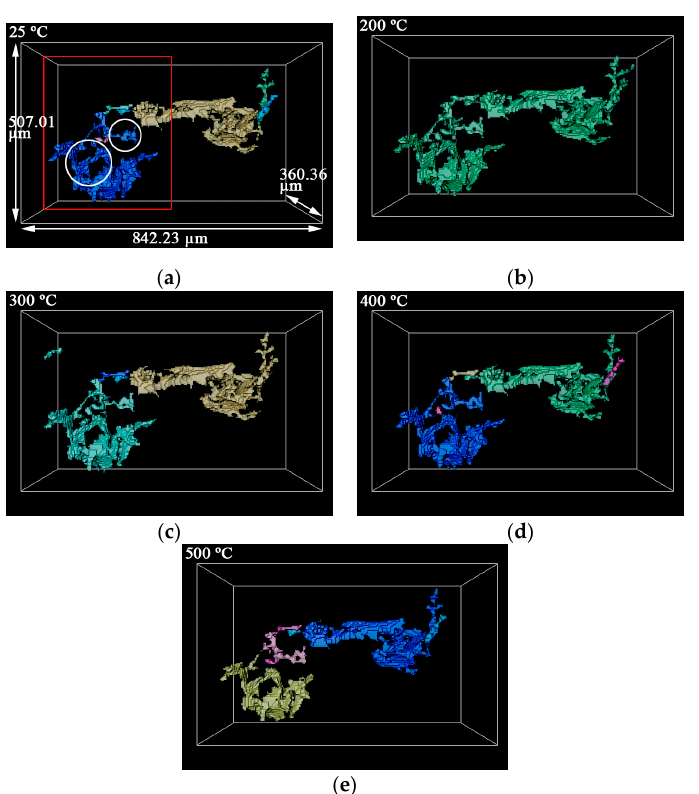
Figure 9. The 3D images of the shape and size change of some branched crack-like (Type Ⅲ ) pores with the temperature. ( a ) 25 ◦ C. ( b ) 200 ◦ C. ( c ) 300 ◦ C. ( d ) 400 ◦ C. ( e ) 500 ◦ C. The CT images in Figure 10a–e correspond to the cross-section that is marked by a red square in Figure 9a. They can more intuitively analyze whether the two pores that are the yellow pore and the green pore, which is long strip pore in Figure 9a, connect. Based on the region marked by a white square at 25 °C, the two pores connect into one at 200 °C and disconnect at 300–500 °C. At 200 °C, the sizes of the pores are slightly larger than the same pores at elevated temperatures. Furthermore, there are some small pores that disappear in the CT images at elevated temperatures. The size marked by arrows is about 17 μ m at 25 °C, 300 °C and 400 °C, 21 μ m at 200 °C and 13 μ m at 500 °C. Based on Figures 9a–e and 10a–e, with the increase of volume at 200 °C, some near-branched pores connect into large pores that are mainly Type Ⅲ pores. Additionally, the pore separates into two or more pores with an increasing temperature because the weak connection is broken with the decrease of volume. The connection or disconnection of adjacent pores is one of the reasons for the amount change of Type Ⅲ pores with an increasing temperature.